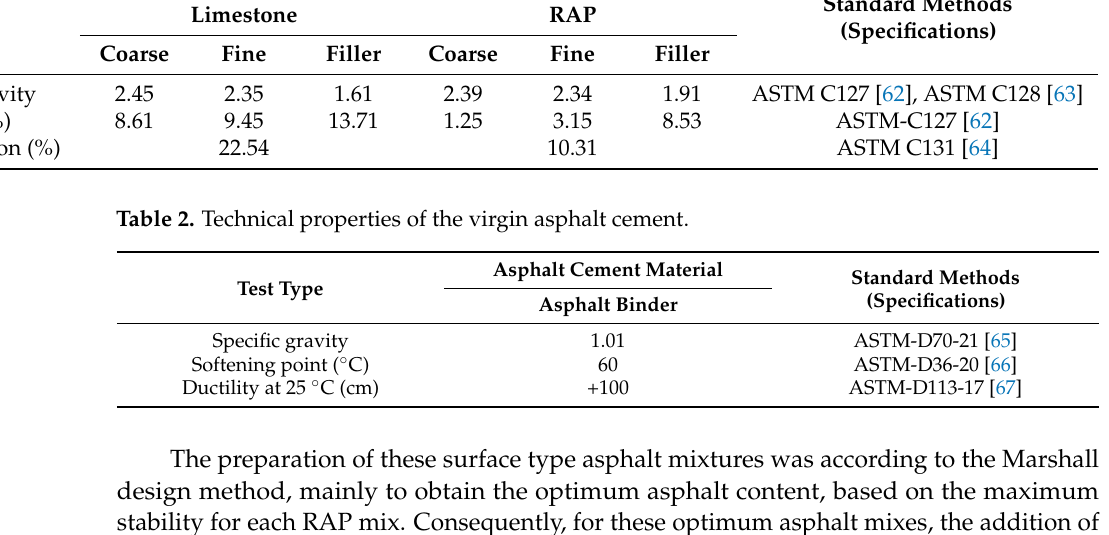
Figure 3. The steel slag material used before and after being crushed. Marshall stability and flow tests were conducted in two phases. The first phase included mixes containing RAP materials that were prepared with various asphalt levels to determine their optimum asphalt content (OAC); therefore, in the second phase, new RAP mixes with the corresponding OAC at different percentages of additives were prepared and tested. 3. Results and Discussion 3.1. Reclaimed Asphalt Pavement The test results of the first phase evidenced the effectiveness of using the RAP aggregates as a replacement for the natural aggregate with the hot asphalt mixtures. Table 3 presents the test results for the mixes containing limestone only. In general, mixtures with RAP exhibited higher stability values than those made with limestone (see Table 4). The maximum stability values for the 75% and 100% RAP mixes were recorded respectively at a 2% AC level, showing less demand in the asphalt content. On the other hand, the lower percentages of RAP needed additional asphalt cement to attain their maximum stability, as shown in Figure 4a.